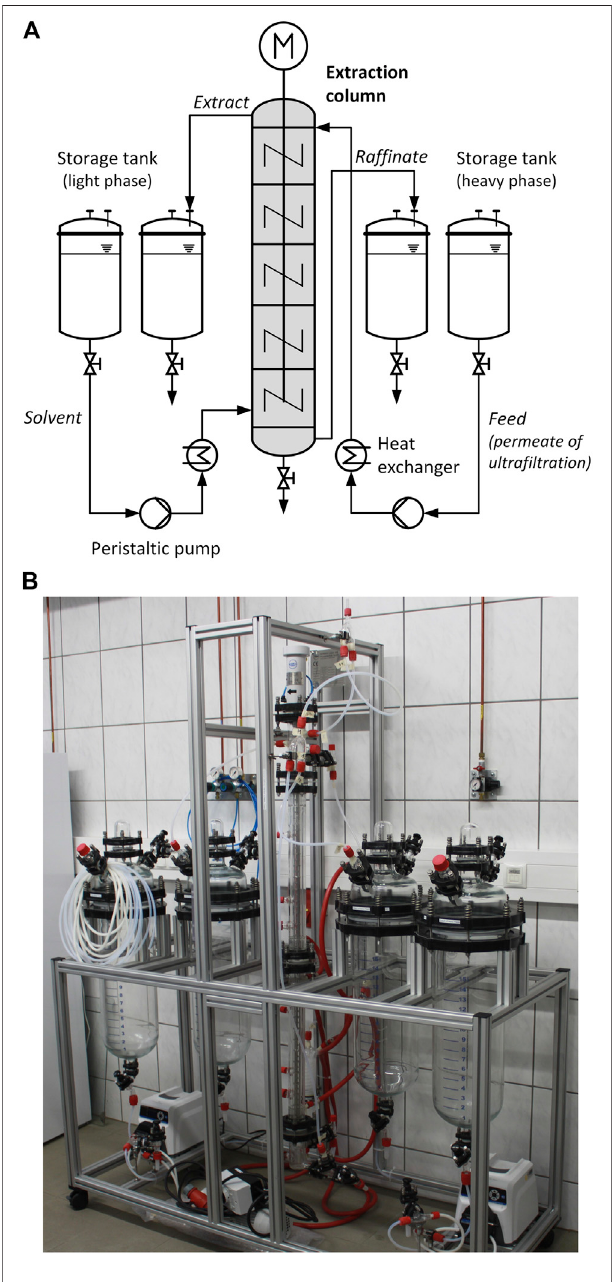
FIGURE 3 | Schematic diagram (A) and photo (B) of the stirred cell extraction